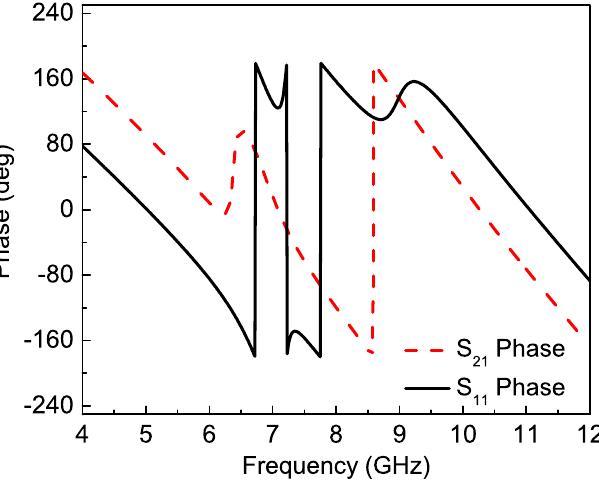
Figure 3. The phase of transmission ( S 21 ) and reflection ( S 11 ) coefficients for the metaresonator sensor. Near resonance frequencies, there is sudden change in